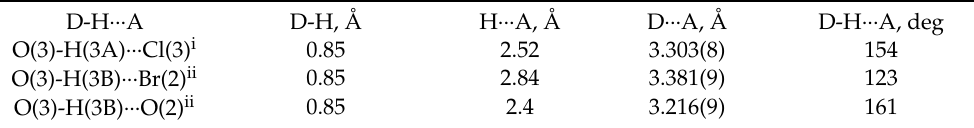
Figure 2. The crystal packing of complex 1 showing ( a ) intermolecular hydrogen bonding which is responsible for the stable packing of the chains; ( b ) intermolecular hydrogen bonding for a 3D framework. Color: the intermolecular O–H ··· O hydrogen bonds are shown as red dashed lines; the intermolecular O–H ··· Cl hydrogen bonds are shown as blue dashed lines. Table 2. Hydrogen bonding